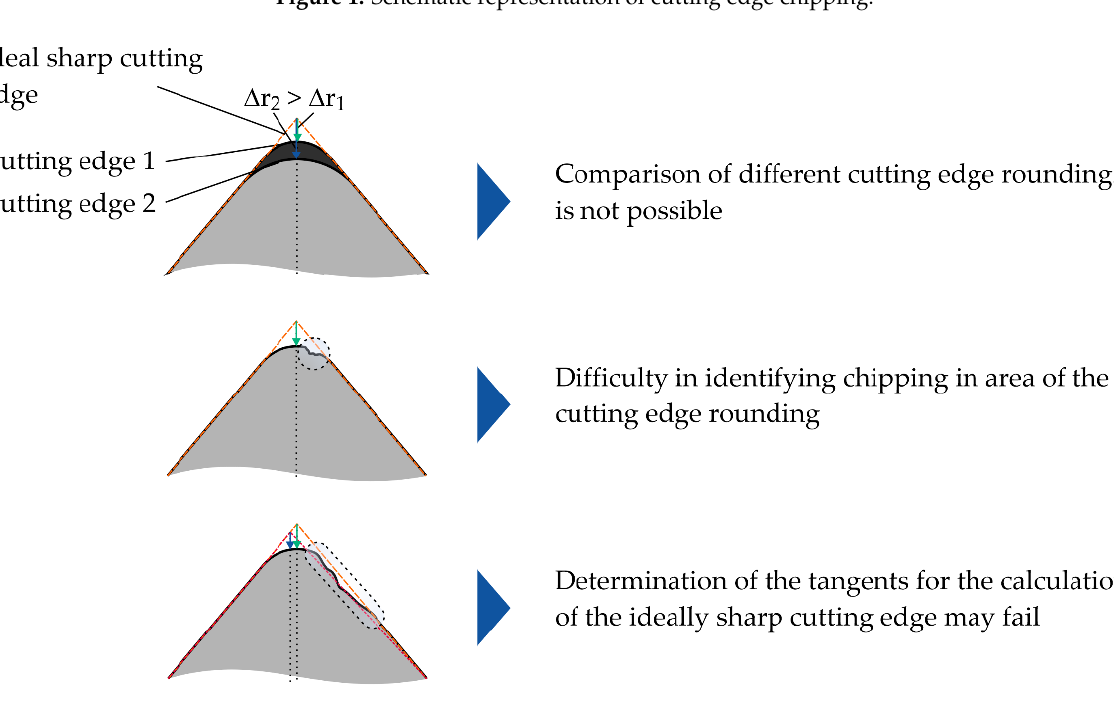
Figure 2. Disadvantages of the ∆ r-method in determining the cutting edge chipping. In scientific works, the cutting edge chipping is often described by the roughness parameters Ra, Rz, Rp, Rv, and Rmax, as well as the parameters of the material removal